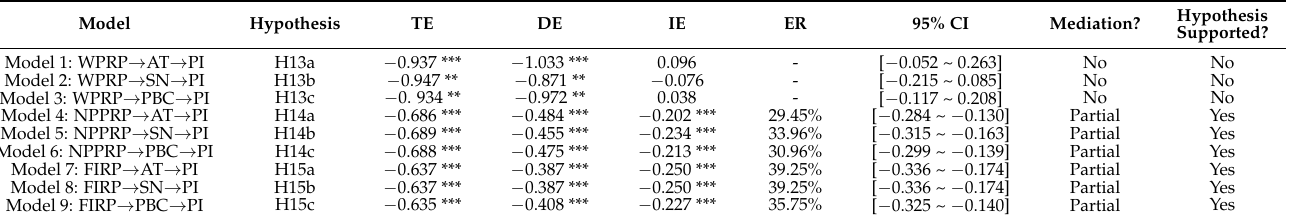
Table 7. Test results of the mediation